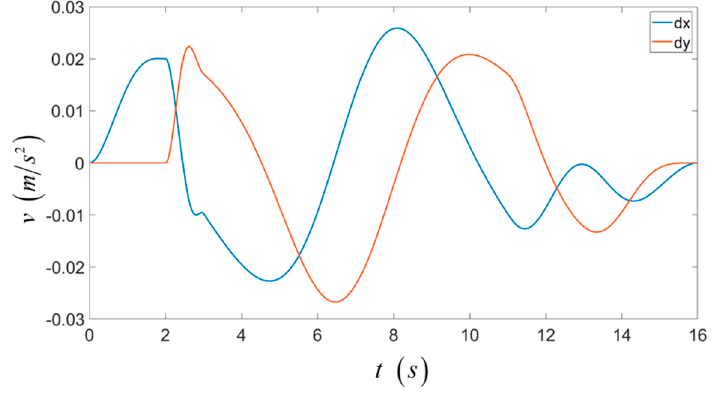
Figure 19. The velocity of moving platform in desired trajectory.